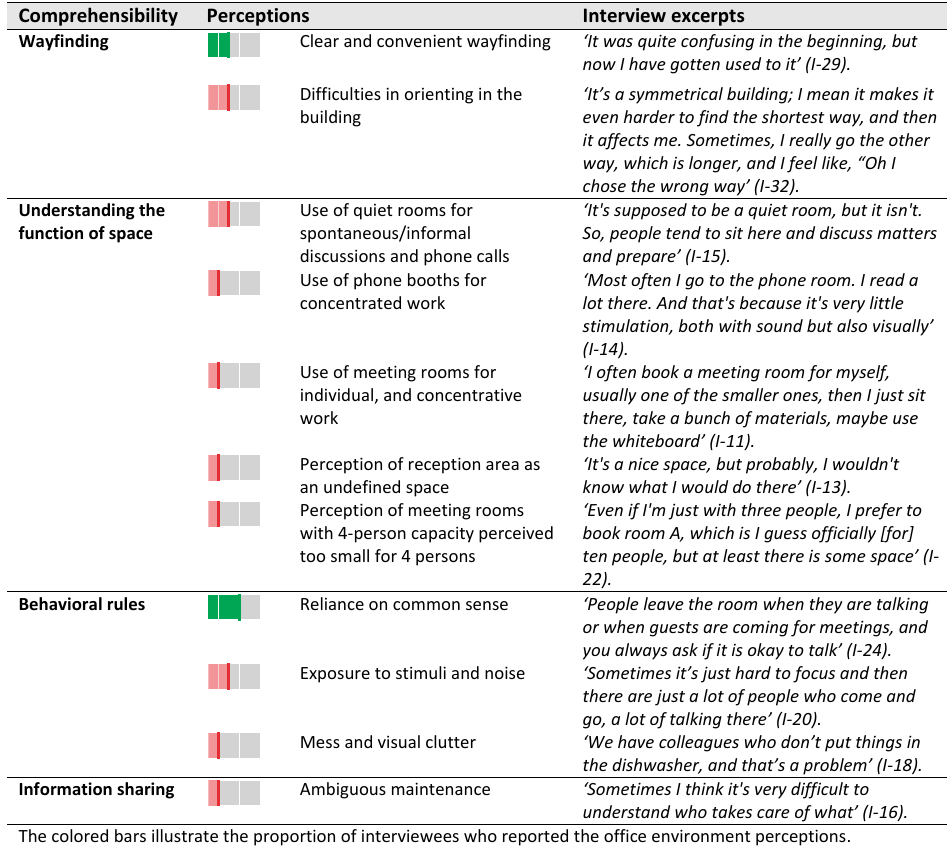
Figure 4. Perceptions of comprehensibility in the office environment as reported in